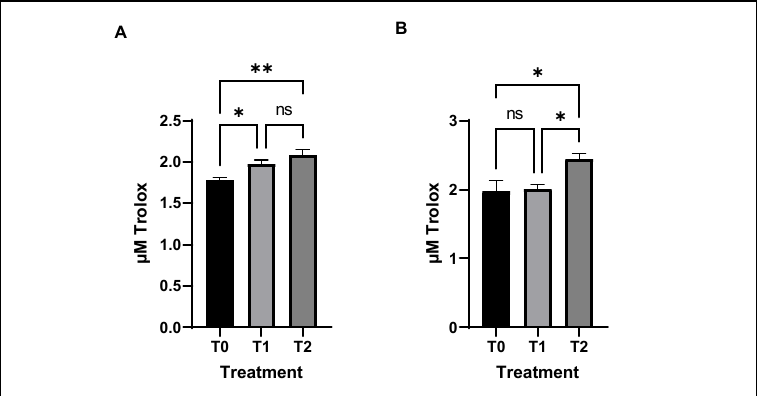
Figure 3. Bar graph illustrating total antioxidant capacity (TAC) as µg Trolox of chicken breast ( A ) and thigh ( B ). Asterisks denote statistical significance ( p > 0.1234 ns, * p ≤ 0.0332, ** p ≤ 0.0021 ); T0: control diet; T1: treatment with 0.00002% Cr; T2: experimental diet supplemented with 0.00002% Cr +2% sea buckthorn leaves (SBL); ns = non-significant.